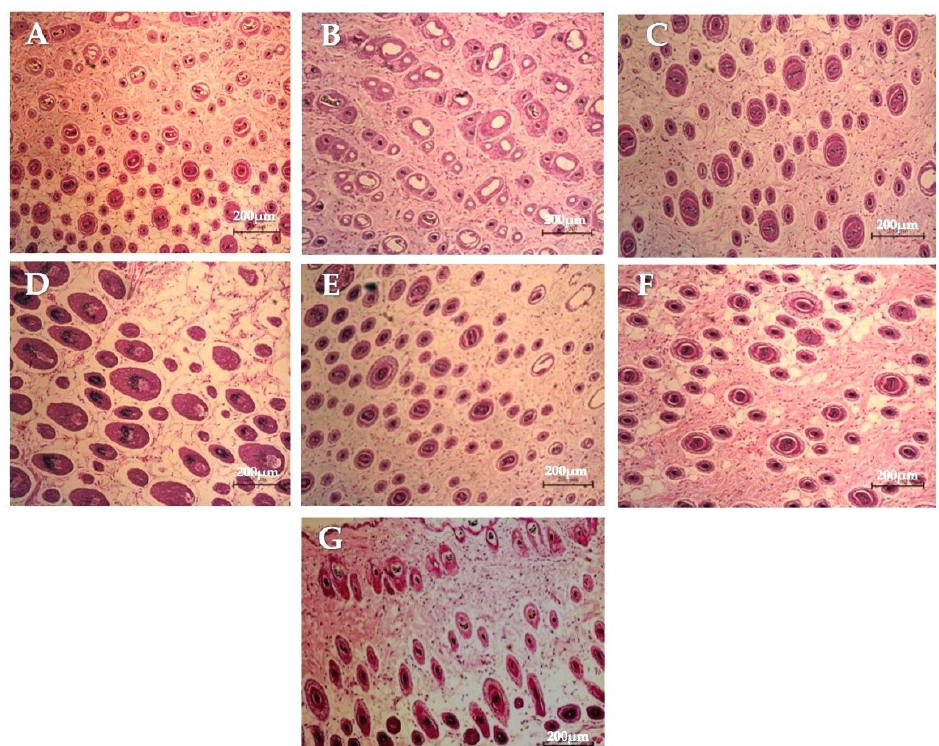
Figure 10. The microscopic images of histopathological examination of longitudinal skin sections treated with different test samples. 100× magnification. ( A ) No treatment; ( B ) blank proniosomes; ( C ) 2% minoxidil solution; ( D ) 0.1% FLP; ( E ) 0.5% FLP; ( F ) 1% FLP; ( G ) 1% FS. The scale bars = 200 µm.